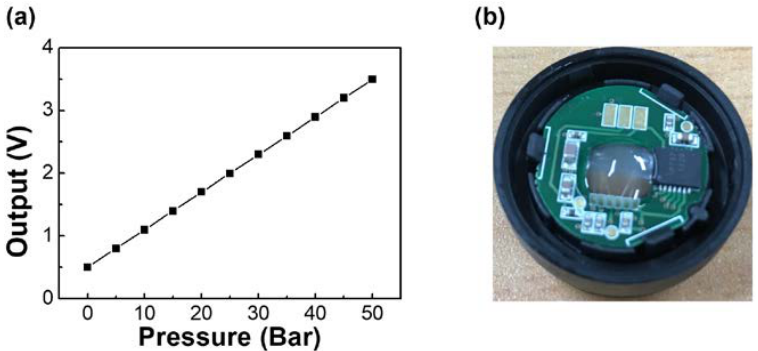
Figure 12. ( a ) Output characteristics of temperature-compensated pressure sensor measured at 25 °C under pressure ranging from 0 bar to 50 bar, ( b ) assembled the sensing element and customized ASIC into plastic